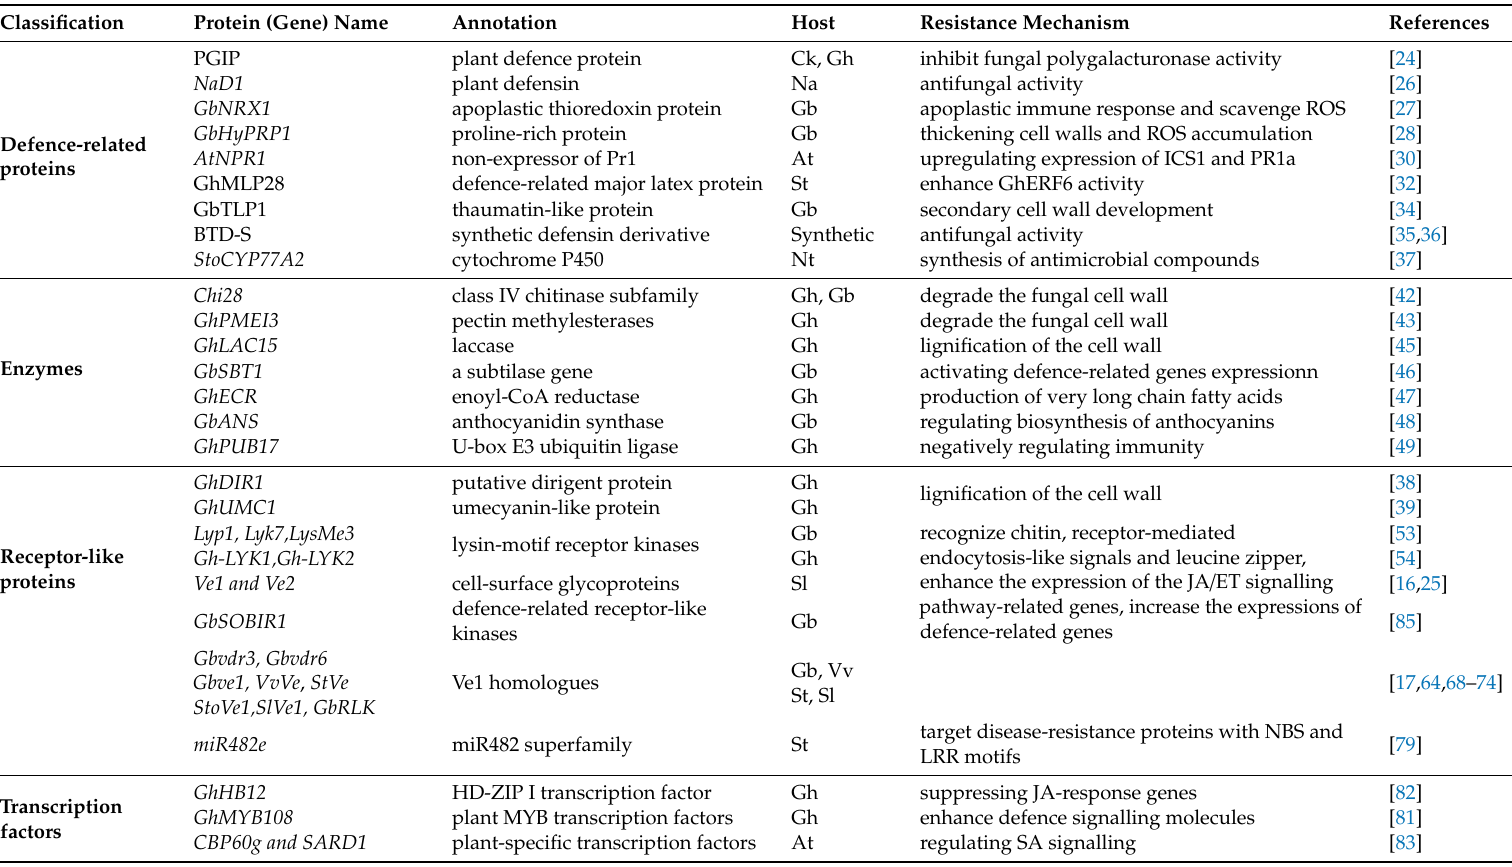
Table 1. Genes related to plant resistance to V. dahlia and their regulatory